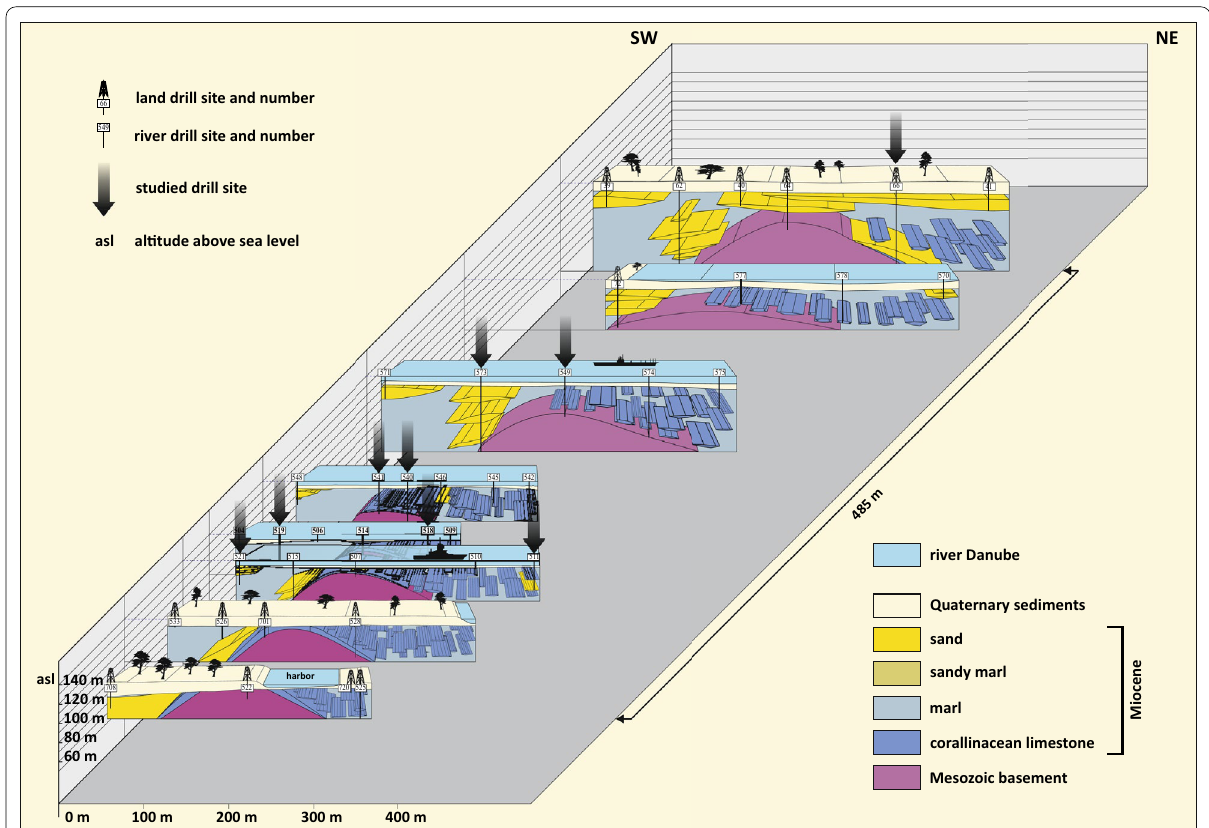
Fig. 14 Schematic reconstruction of the sedimentary environment based on all indicated land and river drill sites. On top of the ridge formed by Mesozoic basement rocks a thin cover of corallinacean limestone is indicated in the SE. The high amount of corallinacean limestone NE of the ridge and coarser siliciclastics in the SW is schematically visualized as discontinuous bodies embedded mostly in